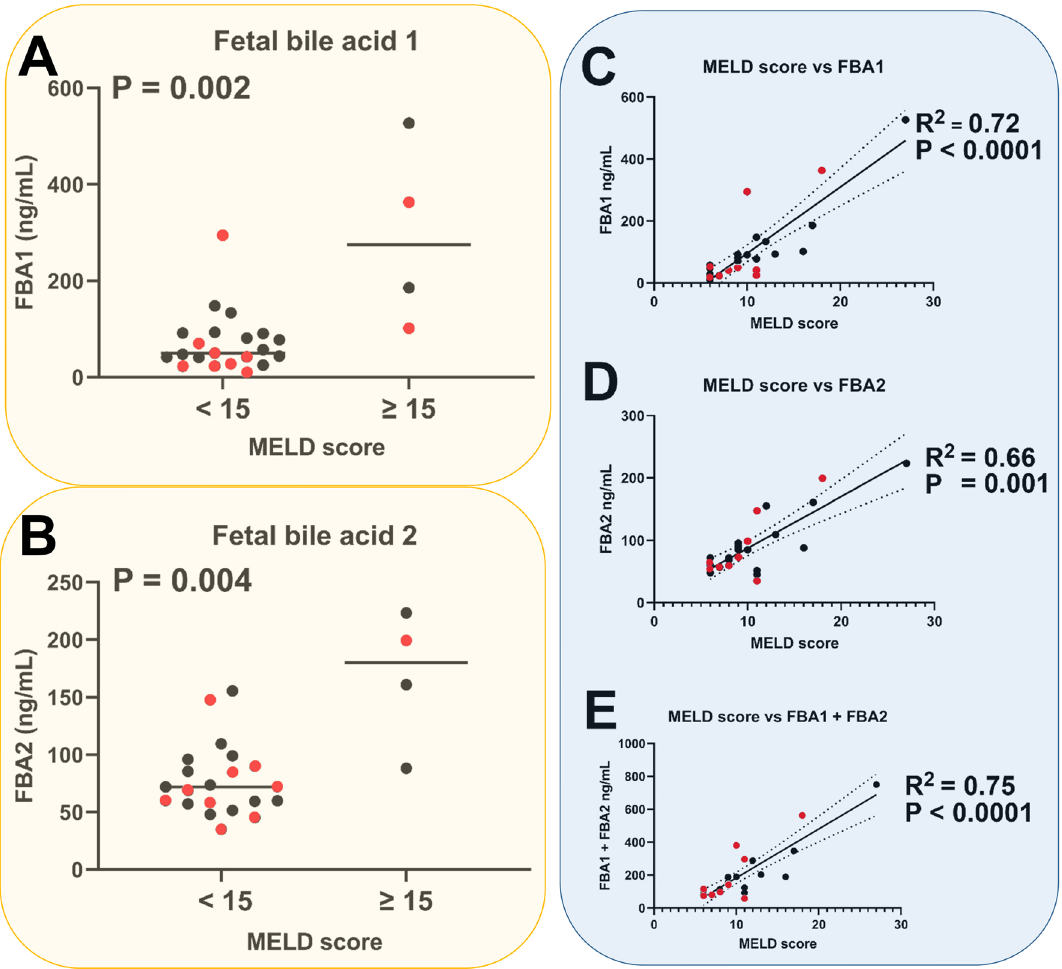
Figure 3. Statistically significant relationship (nonparametric Kruskal–Wallis test) between MELD score and ( A ) fetal bile acid 1 (FBA1) plasma concentration (ng/mL), ( B ) fetal bile acid 2 (FBA2) plasma concentration (ng/mL) and statistically significant correlations (simple linear regression) between MELD score and ( C ) FBA1 plasma concentration, ( D ) FBA2 plasma concentration and ( E ) the sum of FBA1 and FBA2 plasma concentrations. Black symbols represent LC patients without HCC and red symbols represent LC patients with HCC. Dotted lines represent 95% confidence